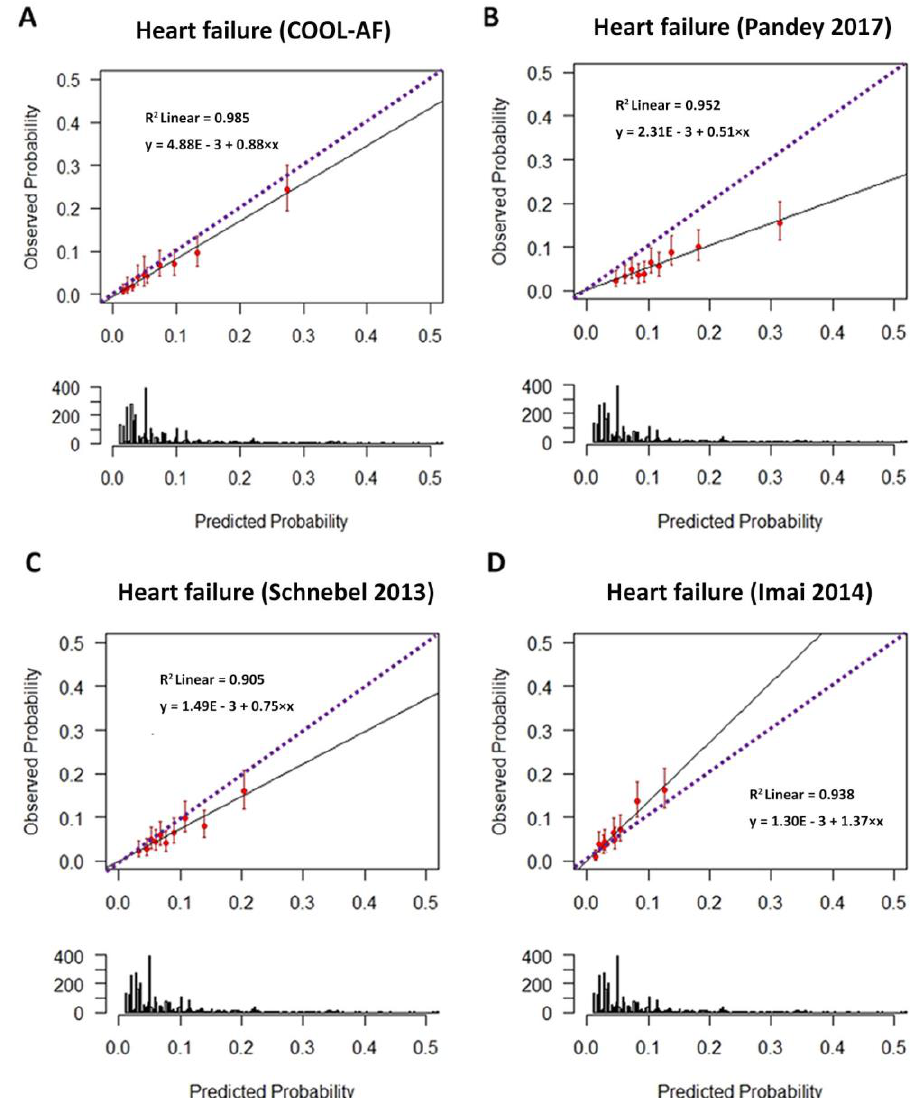
Figure 4. Calibration plots showing a good agreement of the probability of predicated and observed HF events among 10 equal groups of four predictive models. A. COOL-AF B. Pandey et al.[15] C. Schnabel et al.[16] and D. Imai et